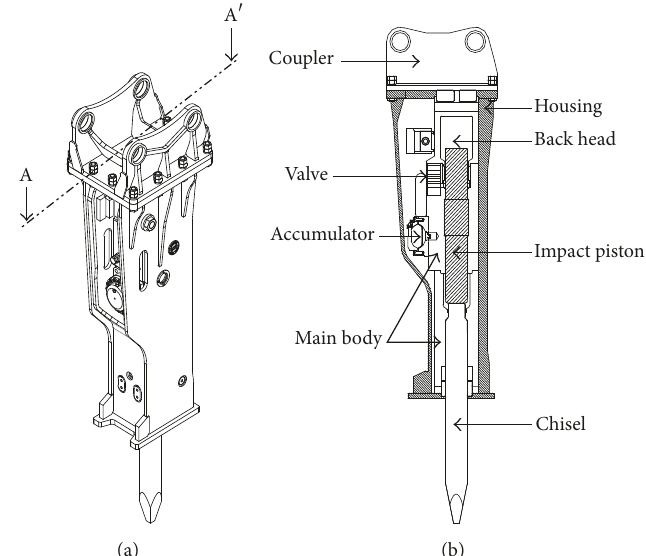
Figure 1: Schematic of the hydraulic breaker: (a) isometric view, (b) cross section A–A 󸀠 .